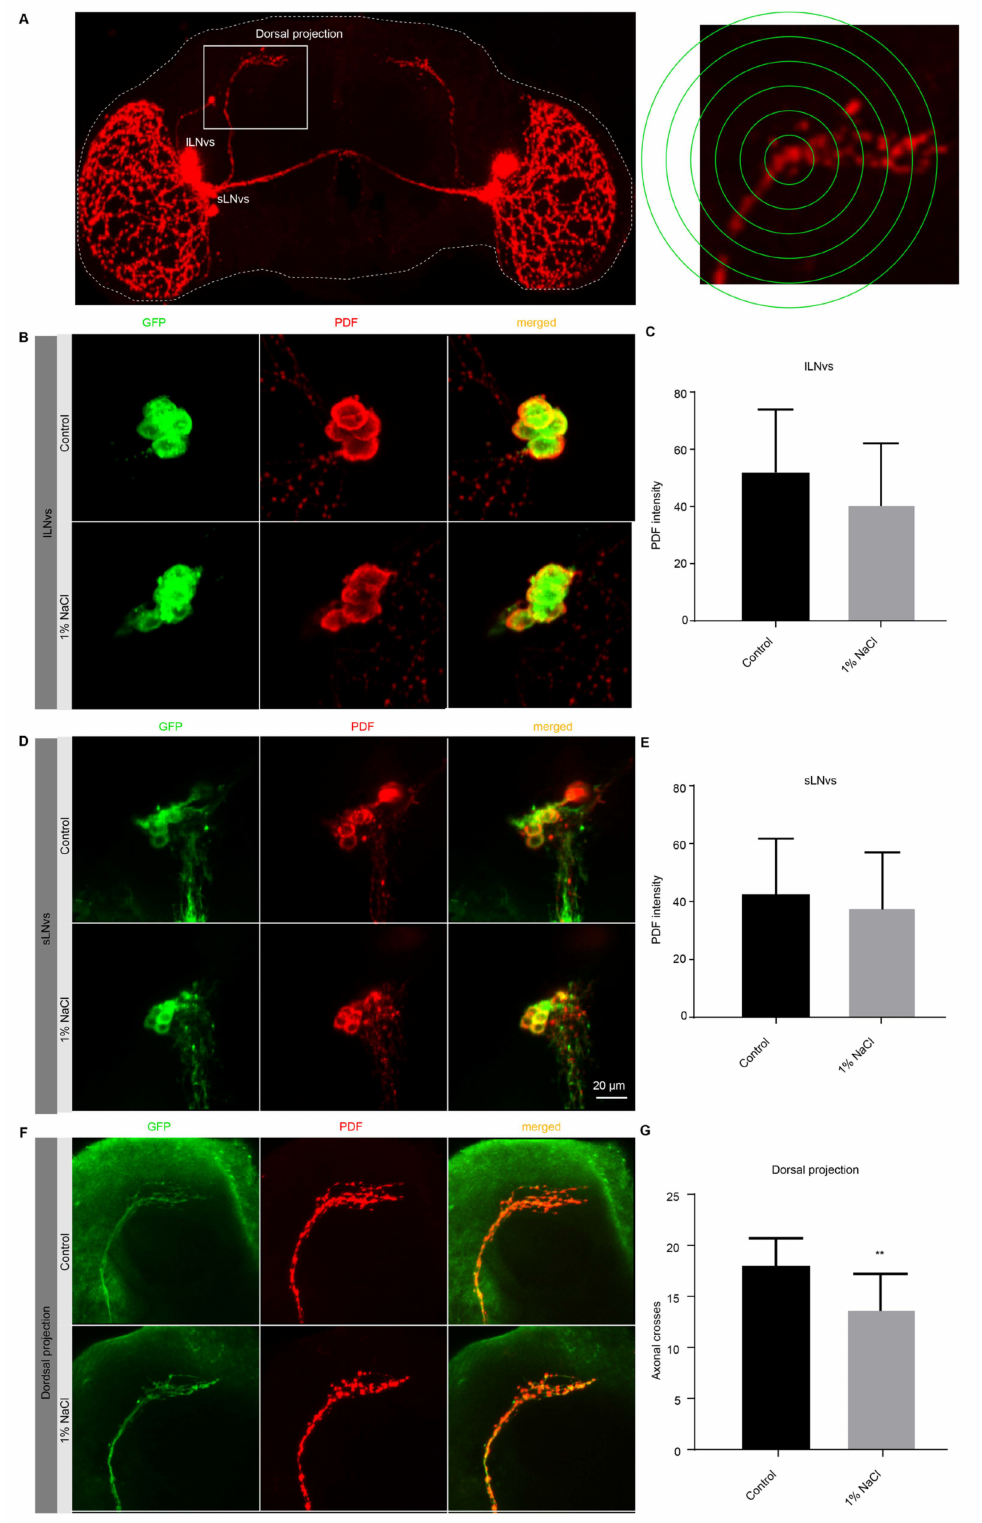
Figure 4. Daily reorganization in PDF terminals is reduced by an HSD. ( A ) Brains were stained with anti-PDF antibodies to show sLNvs, lLNvs, and quantification of axonal PDF projection terminals. ( B – E ) Staining and quantification of PDF content in sLNvs and lLNvs. pdf>mCD8-GFP wild-type brains were fed HSD or normal diet and dissected at ZT2. ( F , G ) Staining and quantification of axonal projection terminals of PDF in flies fed HSD or normal diet. ** p <